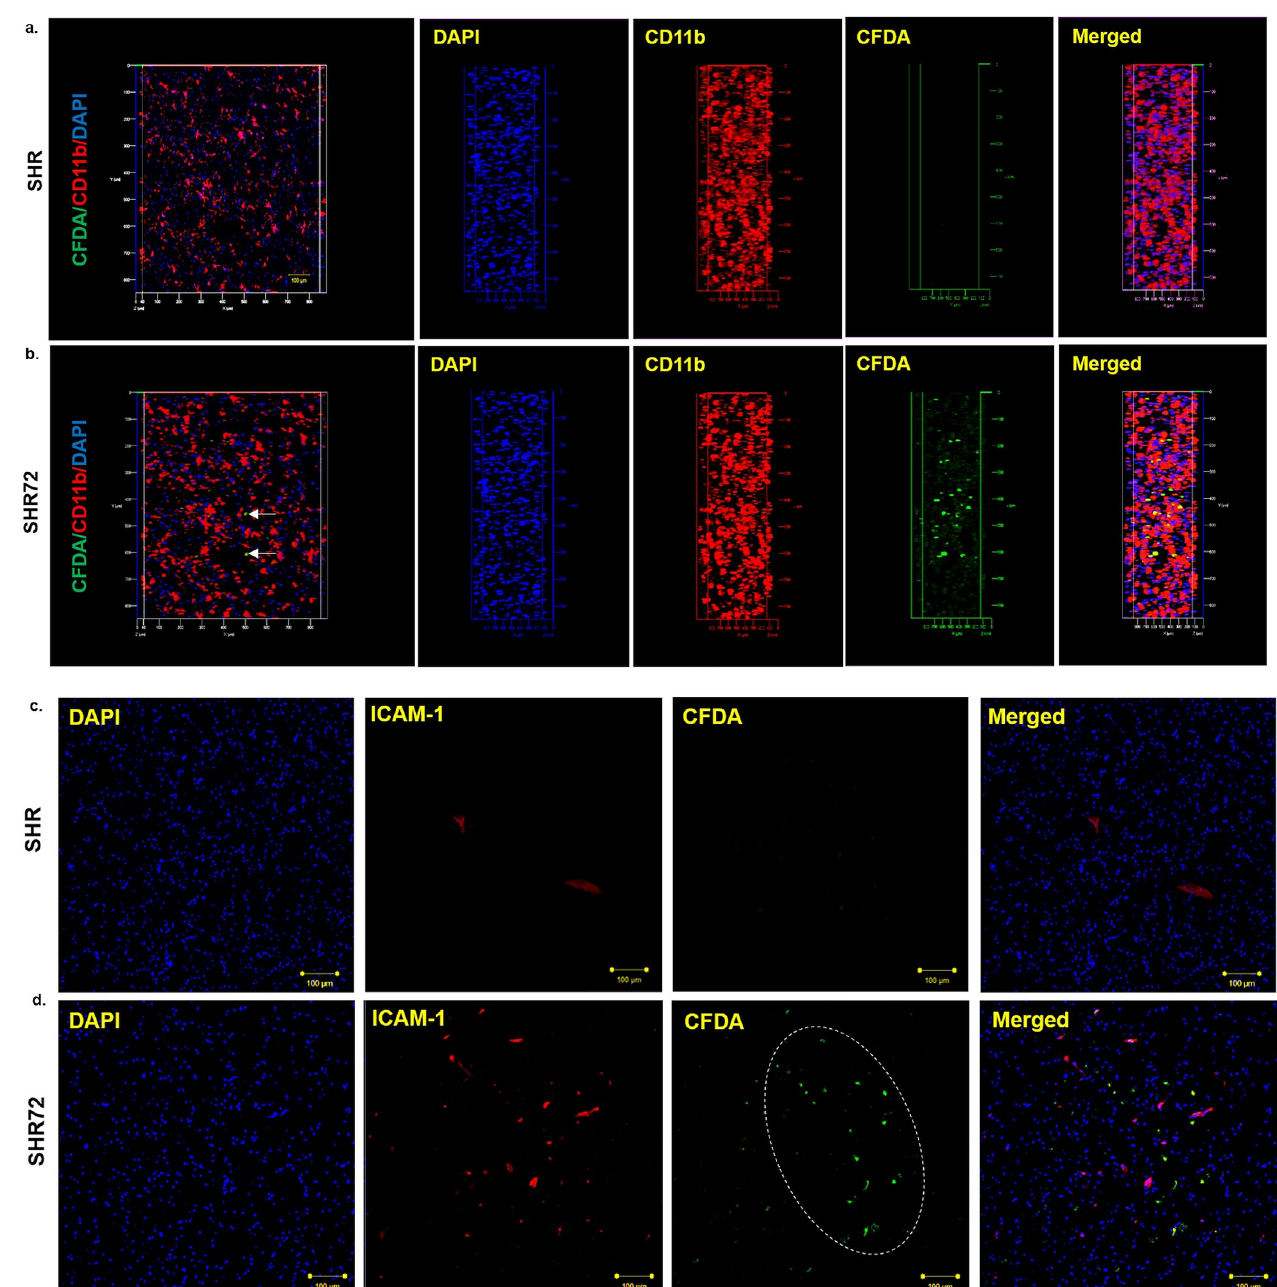
Fig 5. Distribution of CFDA-positive cells. CFDA-positive cells were distributed predominantly in the brainstem and middle brain of transgenic rats, areas with neurofibrillary pathology. (A, B) CFDA-positive PB-MoM cells in control and transgenic rats. In SHR72 animals CFDA-positive cells colocalized with CD11b. (C, D) Infiltration of CFDA positive PB-MoM cells in areas with increased immunostaining for ICAM-1. Scale bar: 100 μ m.